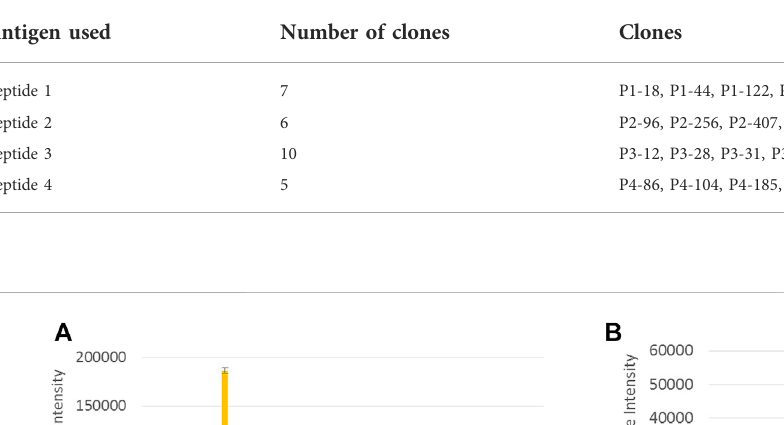
TABLE 3 Hybridoma clones producing antibodies reacting with DENV NS1 peptides.